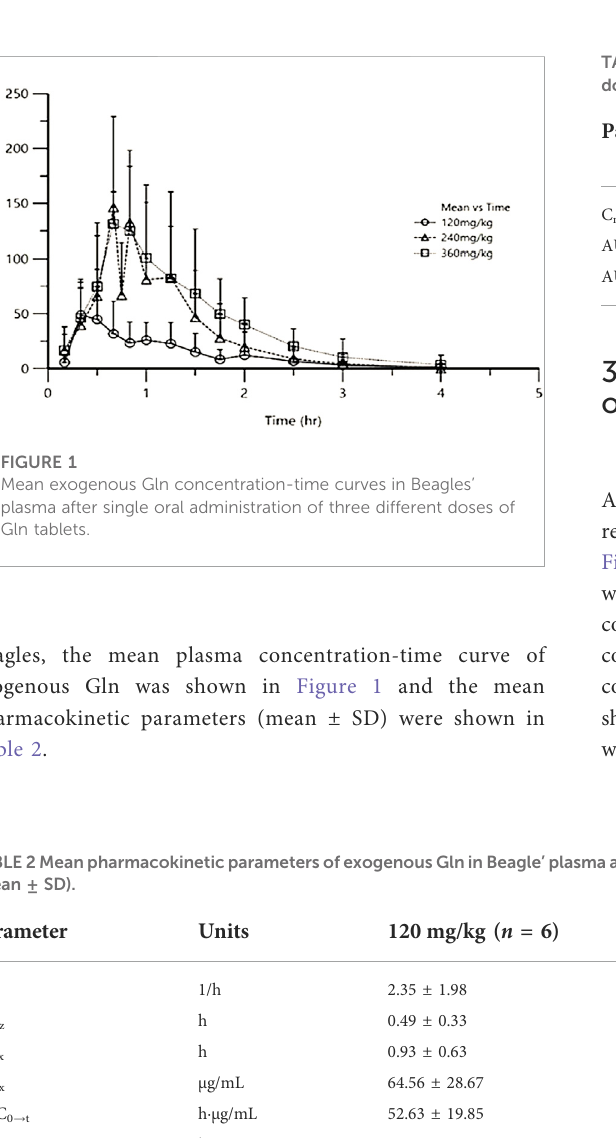
TABLE 3ResultsofANOVAfor themainpharmacokinetic parameters- dosage of three different dosage